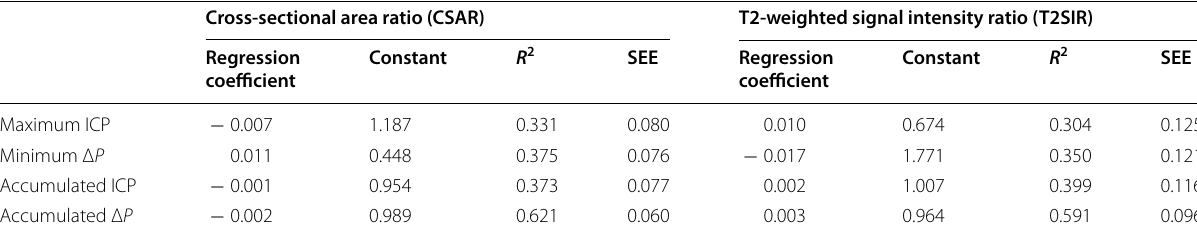
Table 3 Results of simple linear regression analyses of the associations between the ICP data and the MR imaging